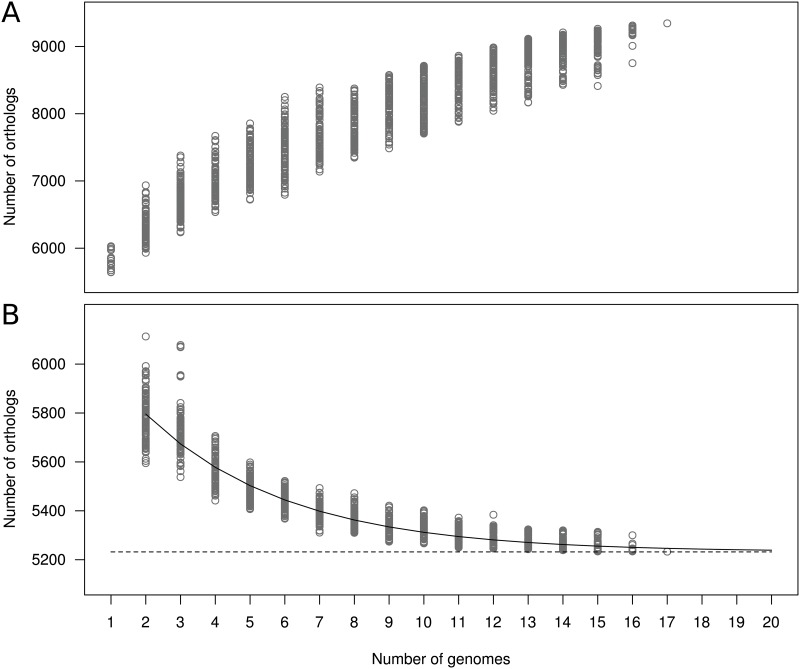

Pseudomonas aeruginosa pan (A) and core (B) genome size according to the number of sequenced genomes (n).The amount of shared orthologs is plotted as a function of the number of genomes sequentially added. One hundred clusterings for each n value (except for n = 1 and 17) were performed by random selection of n genomes (Table 1). On the panel B, the continuous curve represents the least-squares fit of the function Fc = a.e
-b.x+c + d to data. The best fit was obtained with correlation r
2 = 0.913 for a = 1.03, b = 0.24, c = 4.48, and d = 5,232 (95% confidence interval for d = 5,219–5,245). The extrapolated P. aeruginosa core genome minimal size is shown as a dashed line.